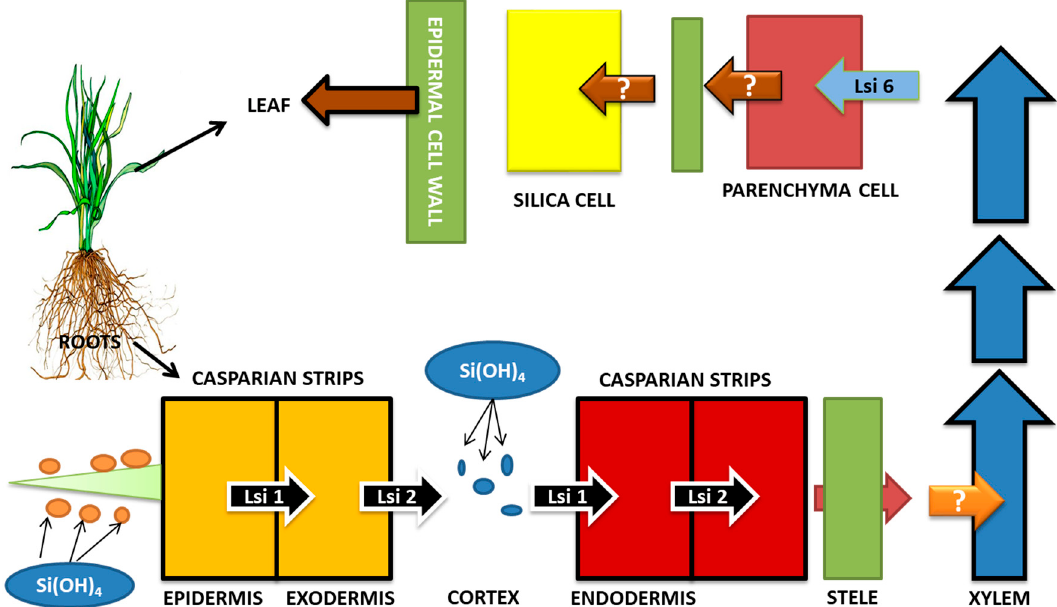
Figure 3. Si transport in Rice ( Oryza sativa ). Influx Si transporters ( OsLsi1 and OsLsi6 ) and efflux Si transporter ( OsLsi2 ) are responsible for the transport of Si from soil to roots, then to stele and xylem, and then upwards towards the shoot. Events of xylem loading and unloading and reloading ( OsLsi3 ) are also involved. Efficient Si uptake and transport leads to better activity of Si in coping up with salinity stress. (Adapted from Khan et al.,